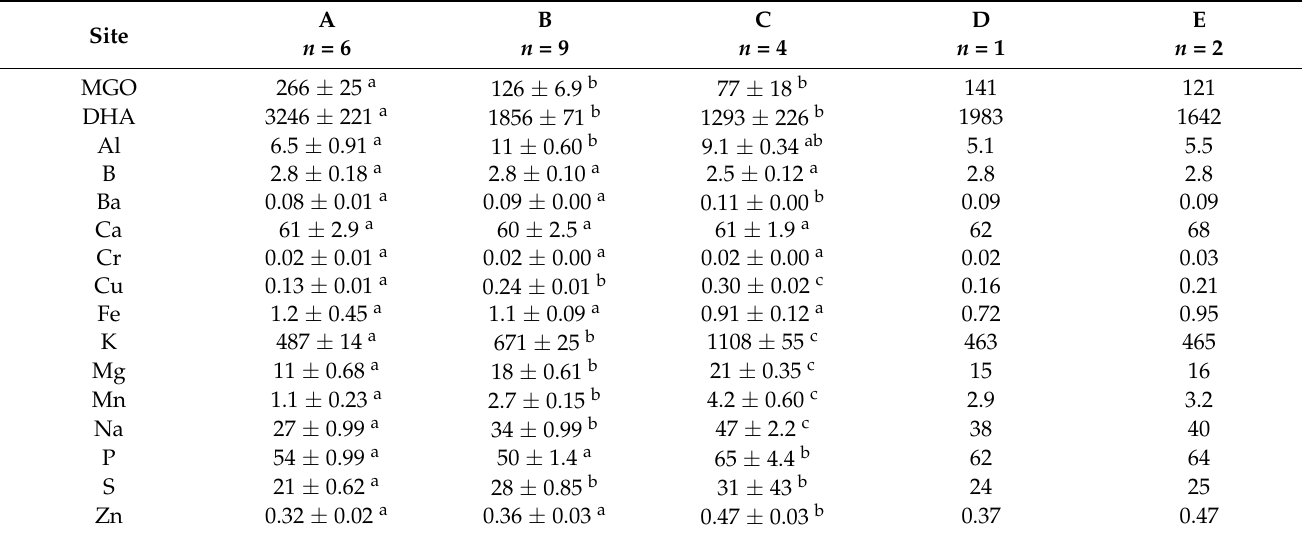
Table 1. Methylglyoxal (MGO), dihydroxyacetone (DHA), and elemental concentrations in honeys from sites A–E. The locations of the sites are shown in Figure